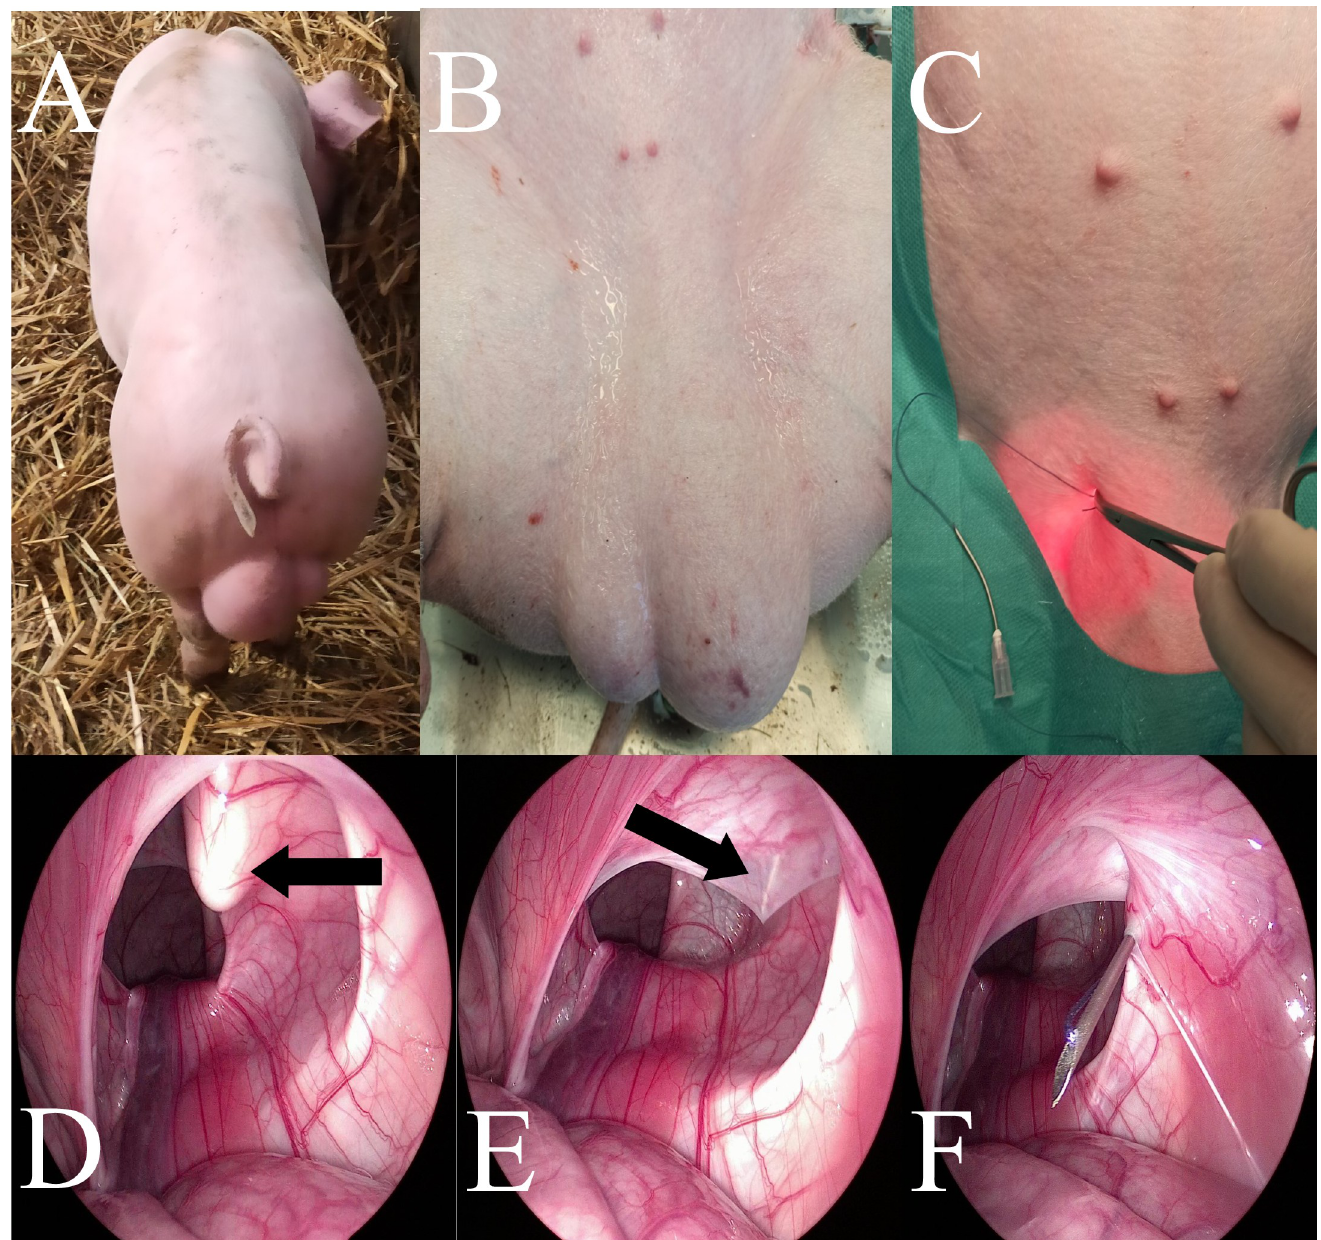
Fig 2. A, B—Preoperative appearance of the left inguinal hernia in the upright position—A and dorsal recumbency—B. C, D—Determination of the place of insertion of the needle and the insertion of the suture over the operated inguinal canal (black arrows). C—external image, B—the laparoscopic image of the abdominal cavity. E—Insertion of the needle into the previously designated place and its passage through the outer half of the inner inguinal canal ring (black arrow) —the laparoscopic image of the abdominal cavity. F—Introduction of the suture through the needle to create a loop—the laparoscopic image of the abdominal